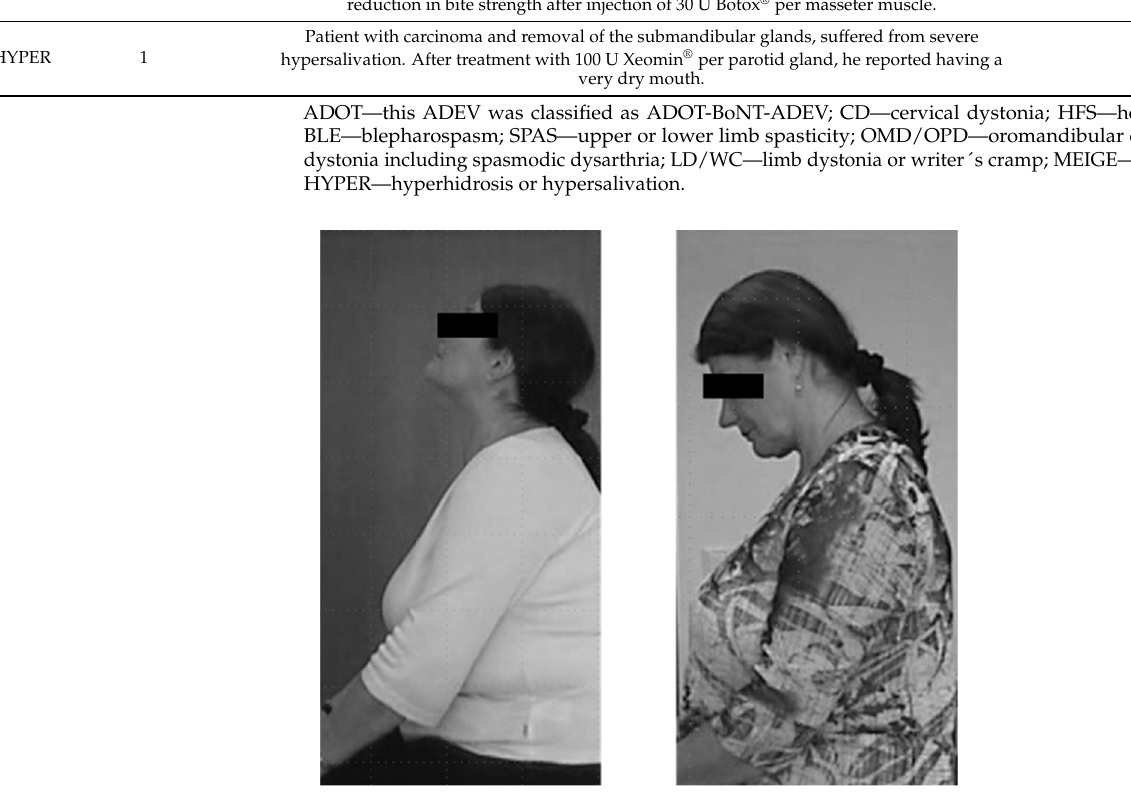
Figure 1. This patient suffers from “retrocollis and retrocaput” (left side). One week after injection of a low dose (100 U) of abobotulinumtoxinA (Dysport ® ), she experienced severe neck weakness and a dropped head.